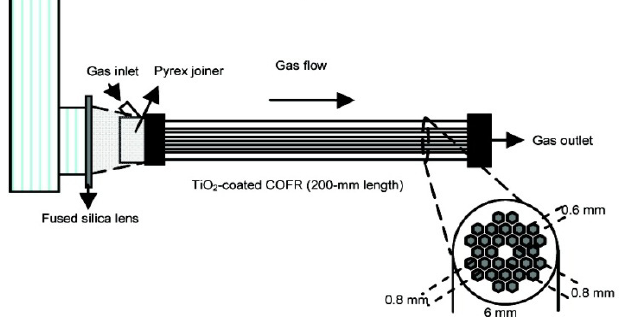
Figure 7. Schematic diagram of Channelled Optical Fiber Reactor (COFR) system for gas-phase photocatalytic degradation of volatile organic compounds